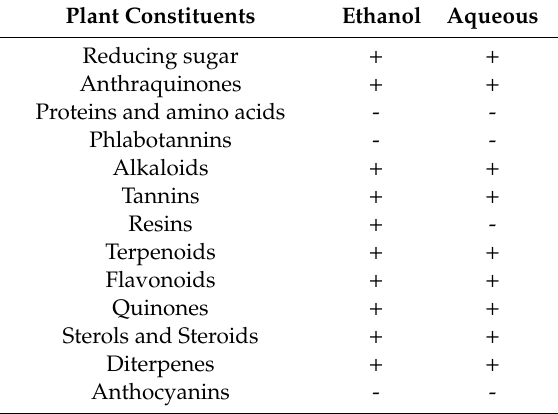
Table 3. Phytochemical screening tests of the ethanolic and aqueous extracts of E.